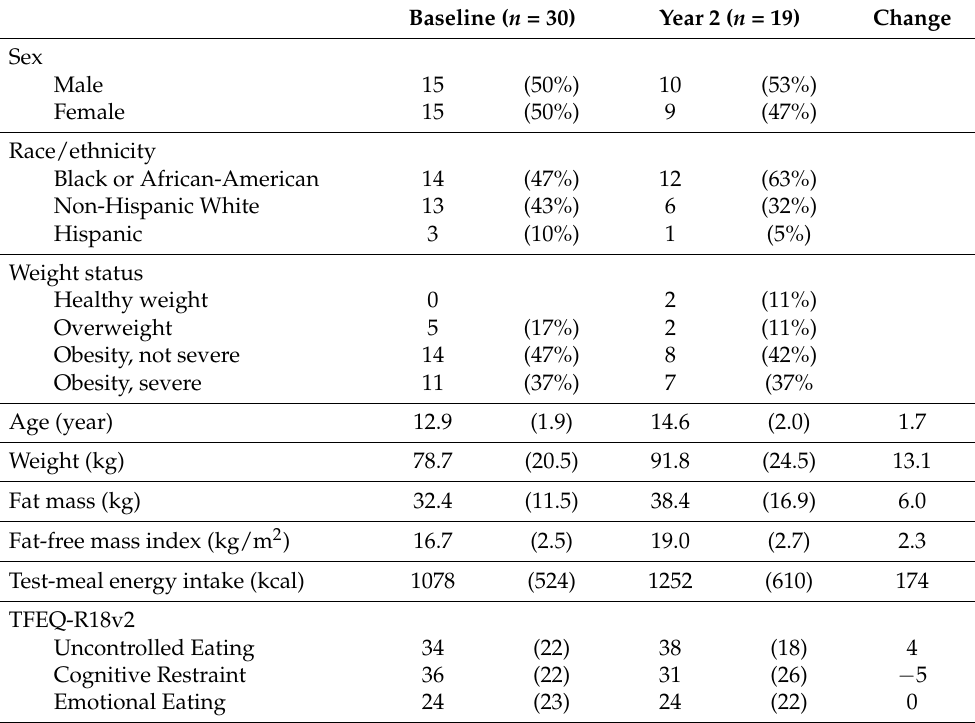
Table 1. Participant characteristics at Baseline and Year 2 follow-up and change over time. Presented as mean (SD) or n (%). Abbreviations: Three Factor Eating Questionnaire Revised 18-item version 2,